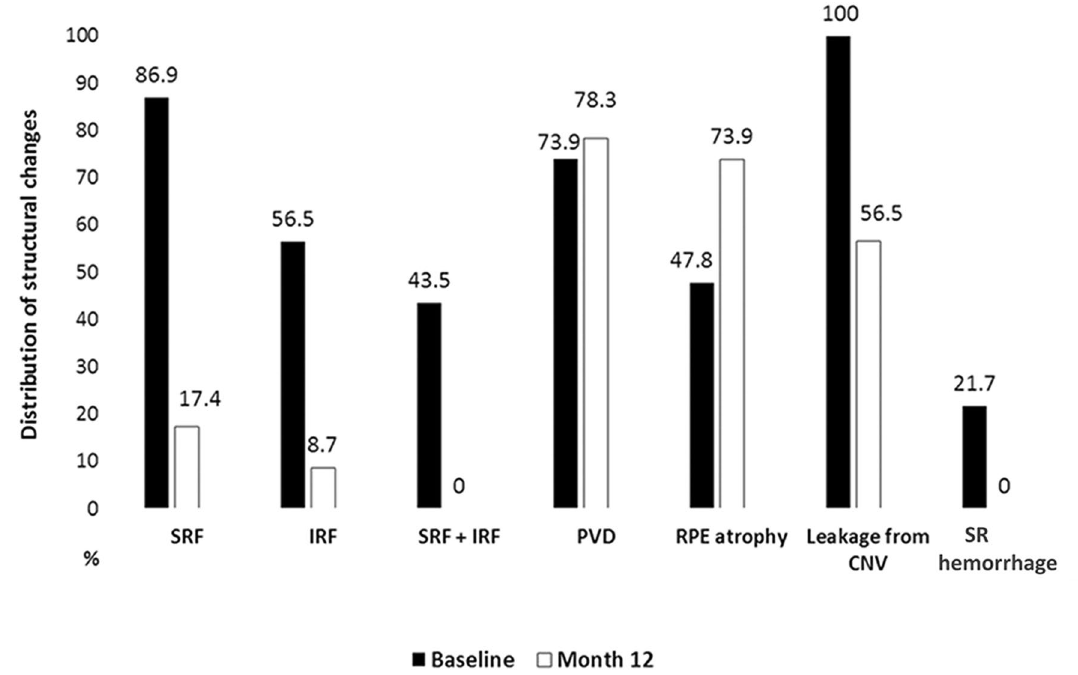
Figure 3. Proportion of patients (%) with key structural findings at baseline and month 12. SRF, subretinal fluid; IRF, intraretinal fluid; PVD, posterior vitreous detachment; RPE atrophy, Retinal pigment epithelial atrophy; Leakage from CNV, leakage from Choroidal Neovascularisation; SR hemorrhage, subretinal